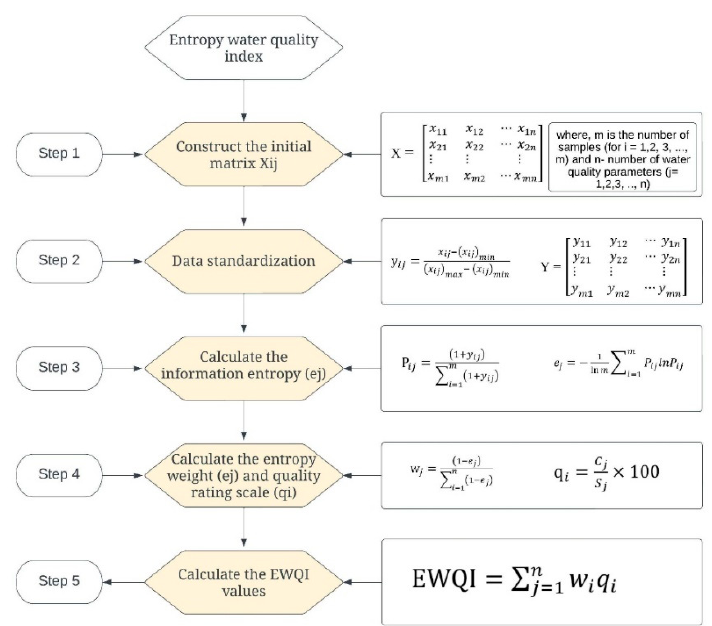
Figure 2. Framework to calculate entropy water quality index.